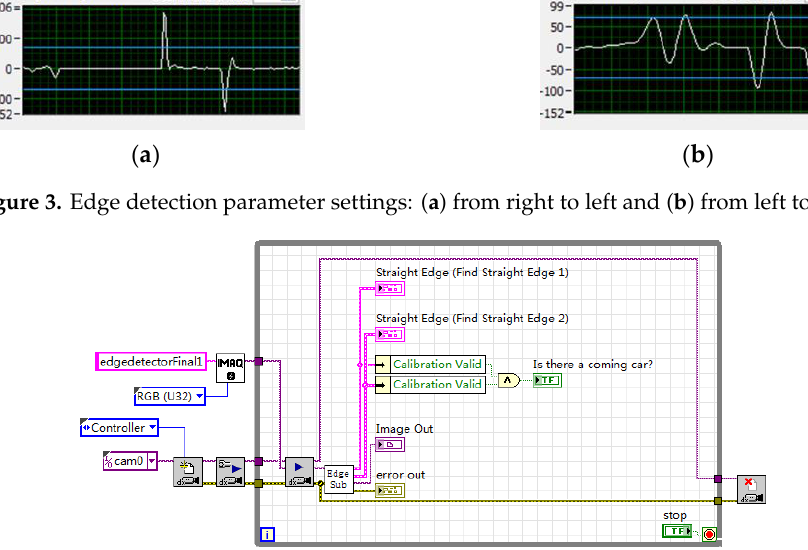
Figure 4. Program block diagram of vehicle target recognition.